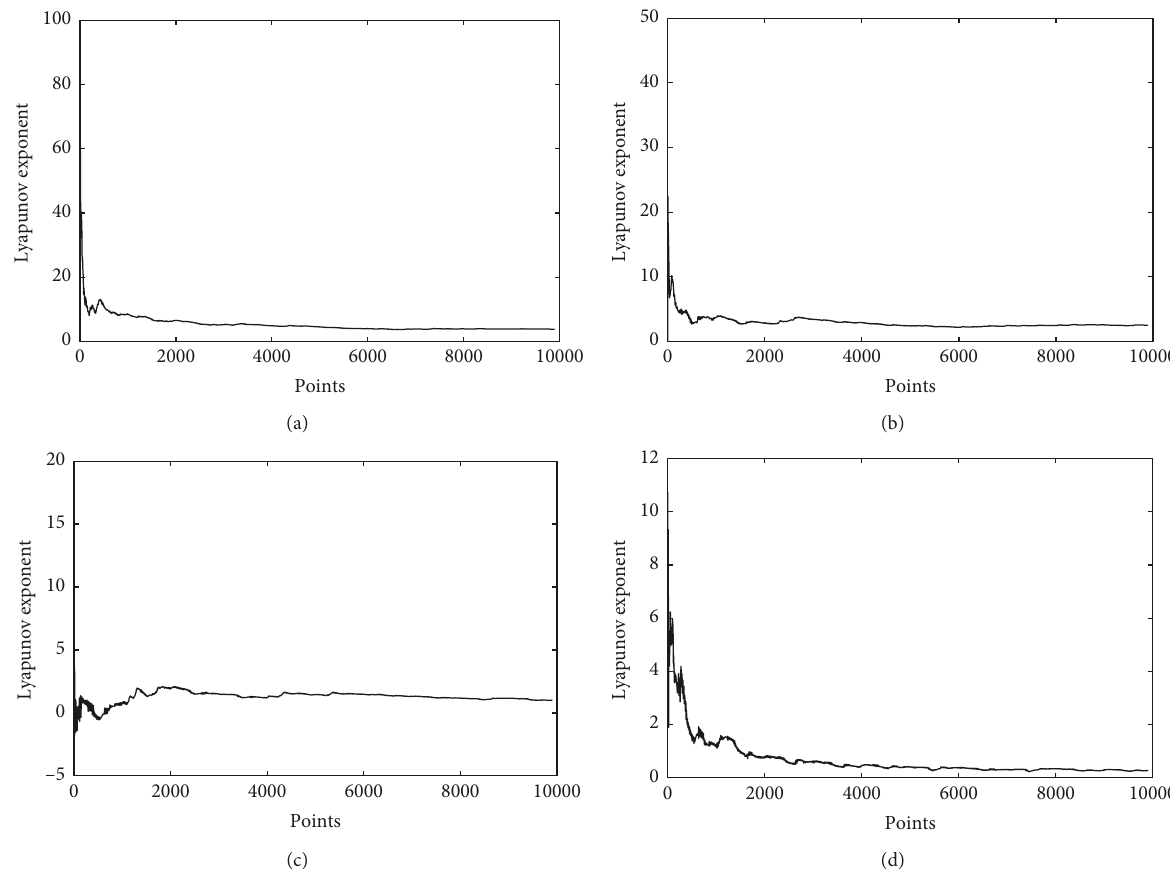
Figure 15: Lyapunov exponent of 2-DOF nine-bar mechanism for different fiction coefficients: (a) c